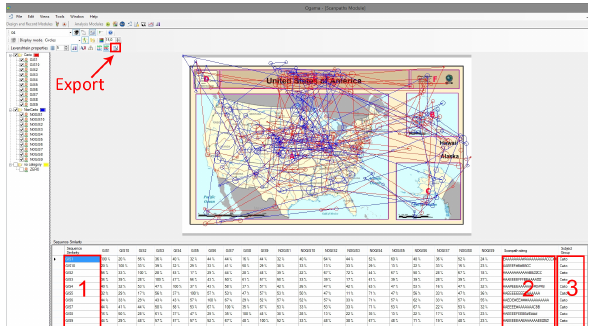
Figure 9. An environment of OGAMA’s Scanpath module. Levenshtein distances between selected participants (and set of AOIs) are calculated and can be exported as a text file. Only Subject names (1), Scanpath strings (2), and affiliation to sub- ject groups (3) is used in ScanGraph.